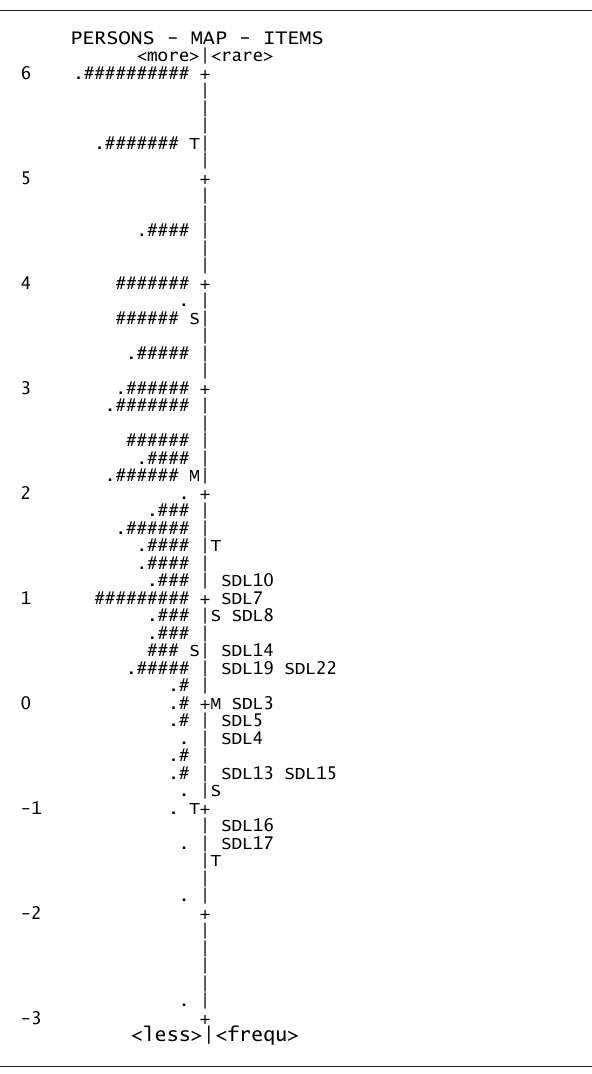
FIGURE 1: Wright item-person map of the Learner Self-Directedness in the Workplace